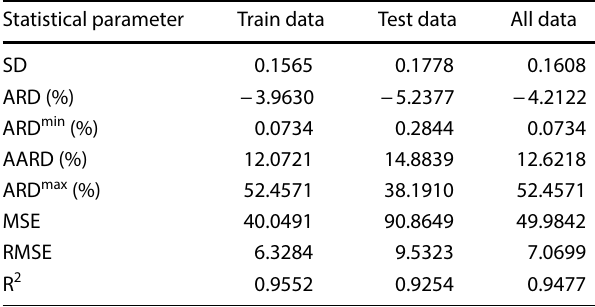
ARD min refers to minimum absolute relative deviation; ARD max refers to maximum absolute